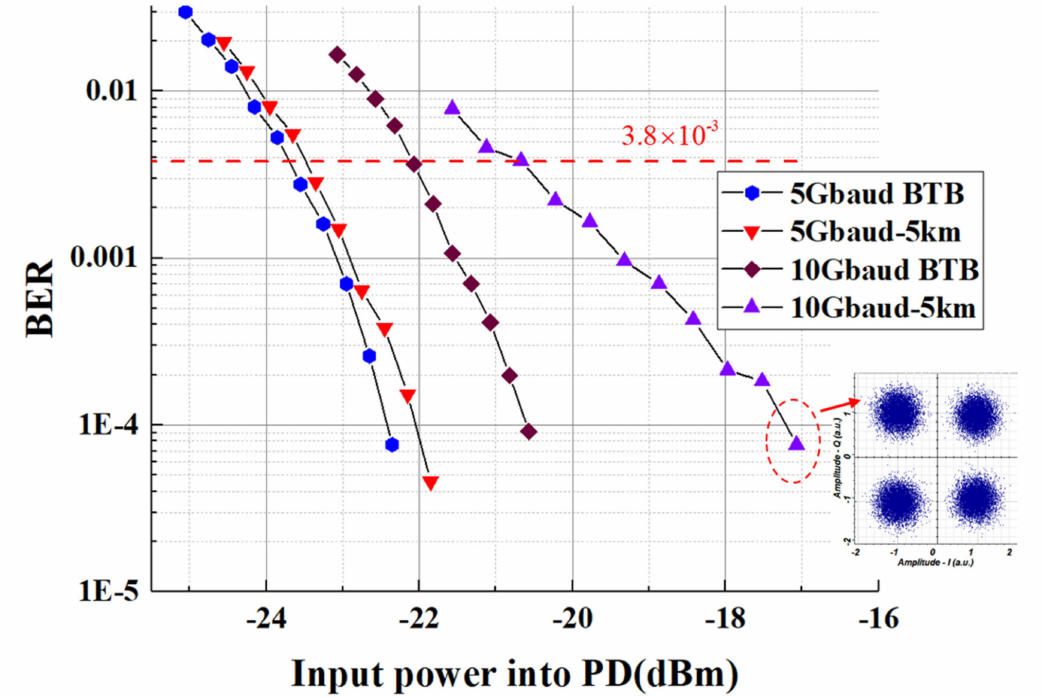
Figure 4. The measured BER results versus launched optical power into